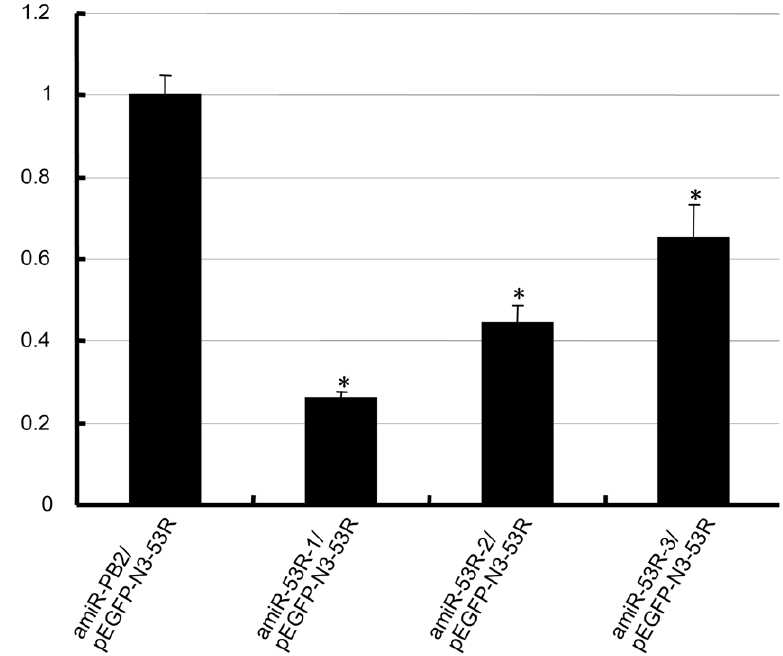
Figure 2. Quantitative analysis of 53R mRNA levels in cells co-transfected with different plasmids. GCO cells co-transfected with pSM155-amiR-53R-1/pEGFP-N3-53R, pSM155-amiR-53R-2/pEGFP-N3-53R and pSM155-amiR- 53R-3/pEGFP-N3-53R, respectively. 53R mRNA level from each group was measured by real-time PCR analysis 72 h post transfection. Group co-transfected with pSM155-amiR-PB2/pEGFP-N3-53R was used as negative control. The value of negative control was designated as 1.0 (n=3). The values represent averages of three independent experiments, with the range indicated ( 6 S.D). *P , 0.05 versus control.